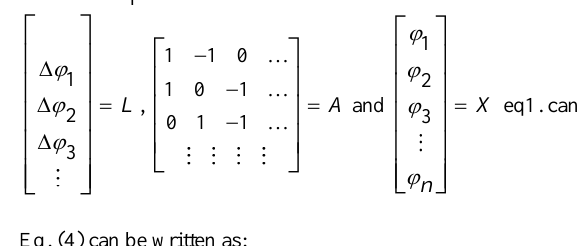
Table 2. Temporal and spatial baselines of the processed interferograms The first image is set to be a known parameter as the time reference